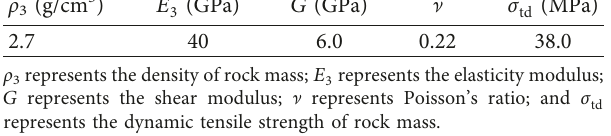
Figure 9: Detailed meshing of explosives, air, and rock mass materials. (a) The notch PBH. (b) The round TBH. (c) Intermediate part model. Table 1: Parameters of the packaged rock emulsion explosive and the JWL state equation [20].